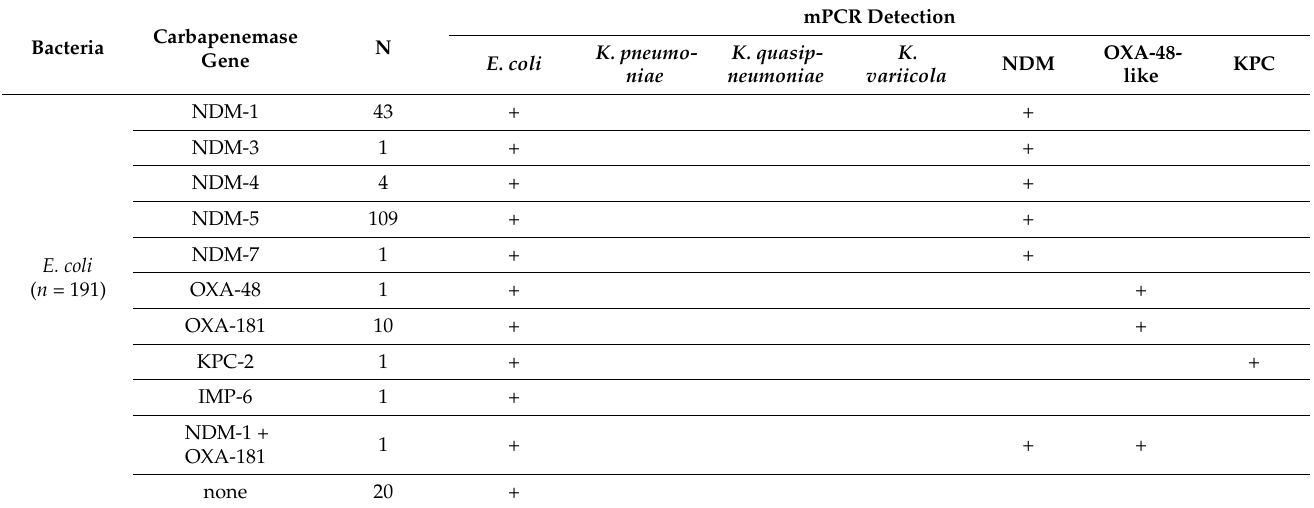
Figure 1. Agarose gel electrophoresis of multiplex PCR-amplified products; lane 1 = Isolate No. C76 ( E. coli with NDM), lane 2 = Isolate No. C163 ( E. coli with NDM and OXA-48-like), lane 3 = Isolate No. C1992 ( E. coli with KPC), lane 4 = Isolate No. C34 ( K. quasipneumoniae with NDM), lane 5 = Isolate No. C110 ( K. quasipneumoniae with NDM and OXA-48-like), lane 6 = Isolate No. AMR353 ( K. quasipneumoniae with KPC), lane 7 = Isolate No. C1985 ( K. pneumoniae with KPC), lane 8 = Iso- late No. C73 ( K. pneumoniae with NDM and OXA-48-like), lane 9 = Isolate No. C75 ( K. pneumo- niae with NDM), lane 10 = Isolate No. C19 ( E. cloacae with NDM), lane 11 = Isolate No. C487 ( C. freundii with NDM), lane 12 = Isolate No. C2135 ( E. asburiae with KPC), lane 13 = E. coli ATCC25922, lane 14 = K. pneumoniae ATCC27335, lane 15 = K. quasipneumoniae ATCC700603, lane 16 = K. variicola ATCC-BAA830, lane 17 = E. coli ATCC-BAA2469 (contain NDM), lane 18 = K. pneu- moniae ATCC-BAA2524 (contain OXA-48), lane 19 = K. pneumoniae ATCC-BAA1705 (contain KPC), lane 20 = negative control, and lane M = 100 bp DNA ladder. Table 1. Enterobacterales species used in this study and mPCR